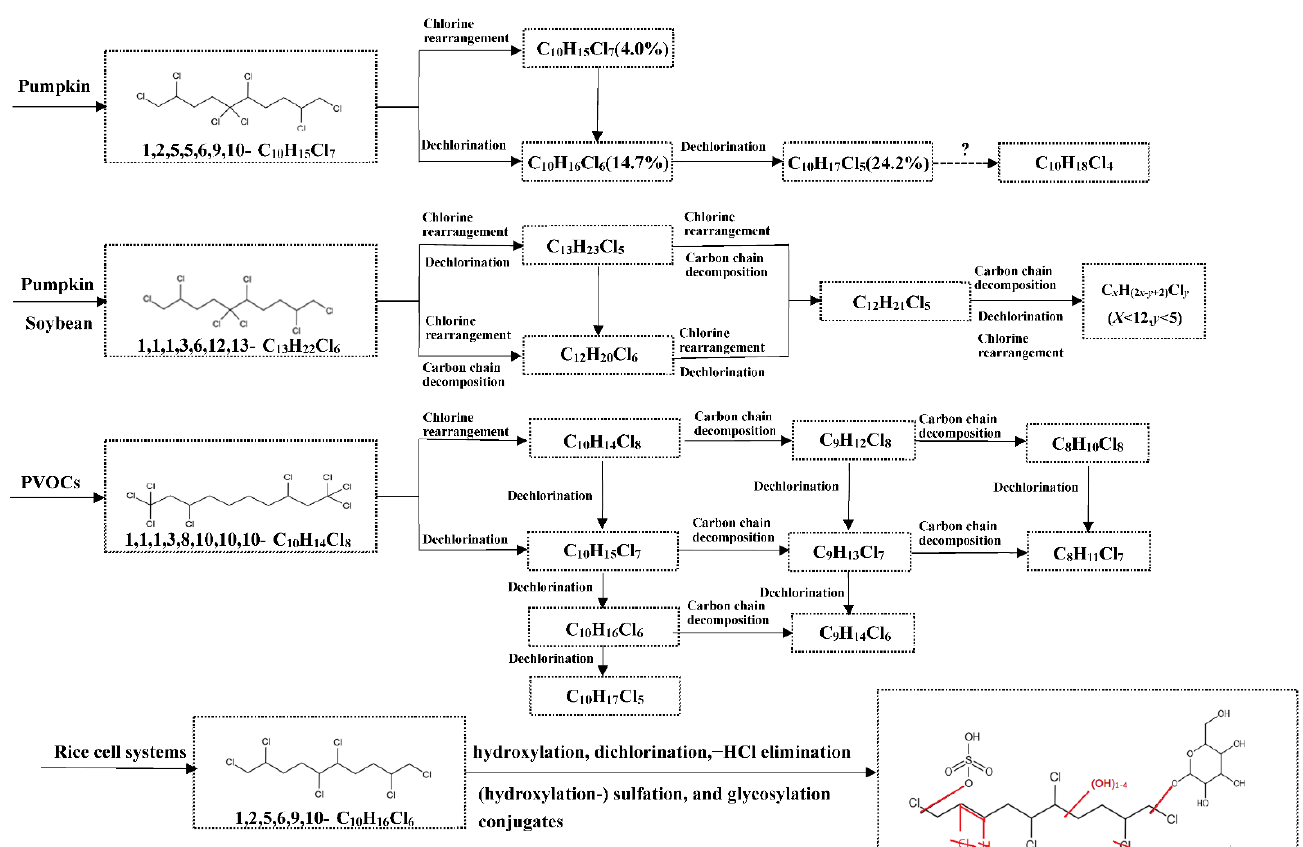
Figure 1. The transformation pathways of 1,2,5,5,6,9,10-C 10 H 15 Cl 7 , 1,1,1,3,6,12,13-C 13 H 22 Cl 6 , and 1,1,1,3,8,10,10,10-C 10 H 14 Cl 8 mediated by pumpkin seedling, rice cell, soybean, and PVOCs, respec- tively. Values in the brackets are the transformation ratios of parent compound to the daughter compounds. The dotted arrow with the question mark is the pathway which possibly occurs but is not able to be detected by GC/ECNI-LRMS.